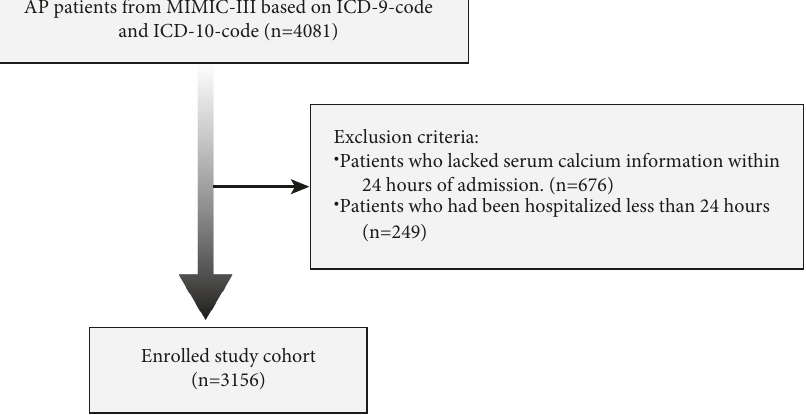
Figure 1: Schematic flow diagram of exclusion criteria for the study